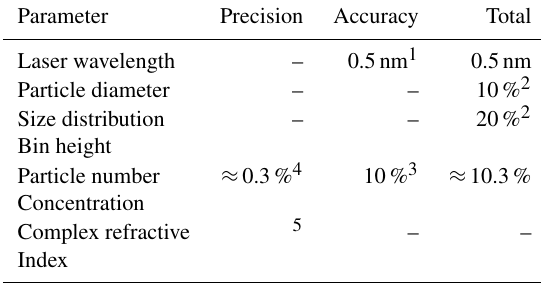
Table 1. Uncertainty on the Mie routine input parameters used to calculate the absorption coefficient of the size-selected nigrosin (and SRFA and PPFA) particles.